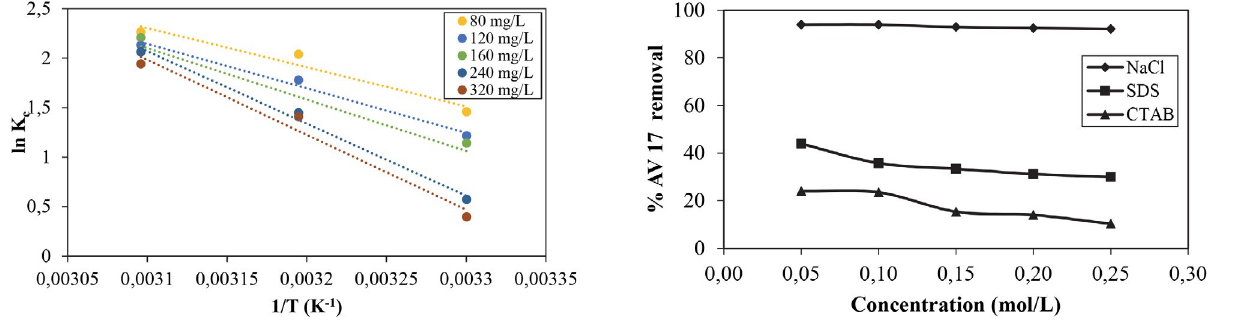
Fig. 12. The estimation of thermodynamic parameters.